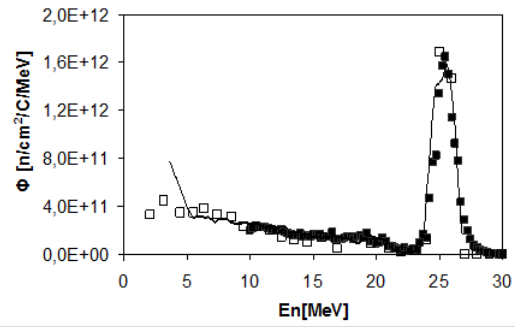
Figure 9. Large vacuum chamber